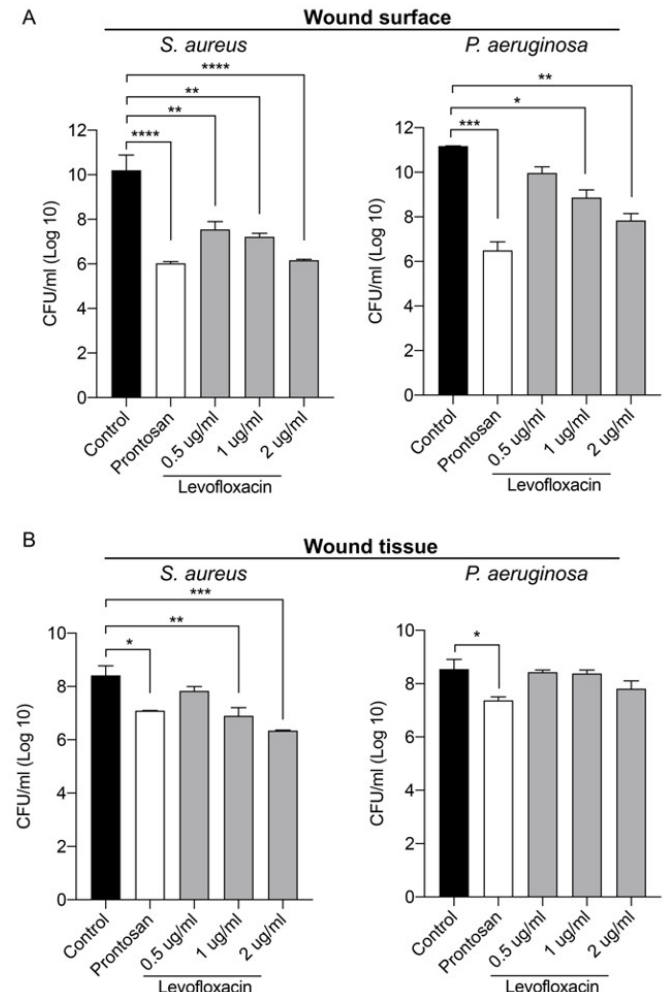
Figure 4. Evaluation of topical antimicrobial treatments in an infected ex vivo wound model. In- fection was induced with either S. aureus or P. aeruginosa by adding 30 µL of a 10 8 CFU/mL bacte- rial solution. Infection was allowed to establish for 2 h prior to addition of 100 µL of treatment (Prontosan or Levofloxacin at the indicated concentrations) to each wound. Tissues were then in- cubated for an additional 2 h prior to sampling. ( A ) Bar chart showing bacterial count from the wound surface. The wound surface was washed twice with PBS, and the number of colony form- ing units (CFU) in the wash solution was quantified. ( B ) Bar chart showing bacterial count from the wound tissue. Tissue samples were collected and homogenized and the number of colony- forming units in the tissue homogenate were quantified. Values were log 10 transformed and are represented as the mean ± SEM ( n = 3). P values were determined using a one-way ANOVA with Tukey post hoc test. Significant results are denoted as * p < 0.05, ** p < 0.01, *** p < 0.001, and **** p <